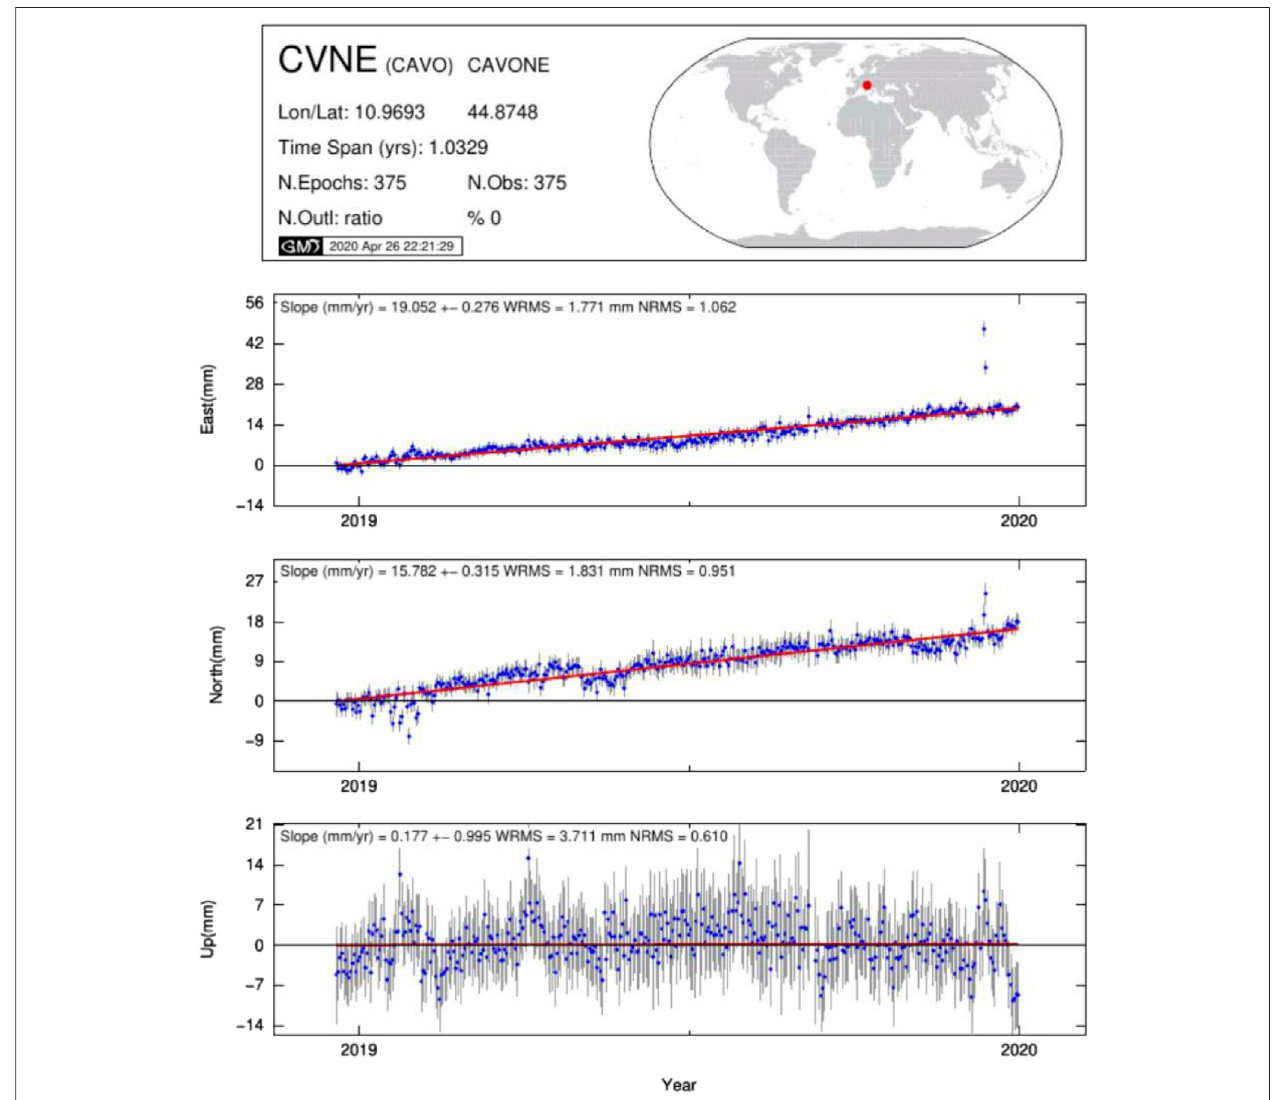
FIGURE8| DisplacementtimeseriesoftheCAVOstationintheIGS14globalreferenceframe.Thegraylinesindicatetheerrorbars(1 σ )andtheredlinerepresents the estimated linear trend.